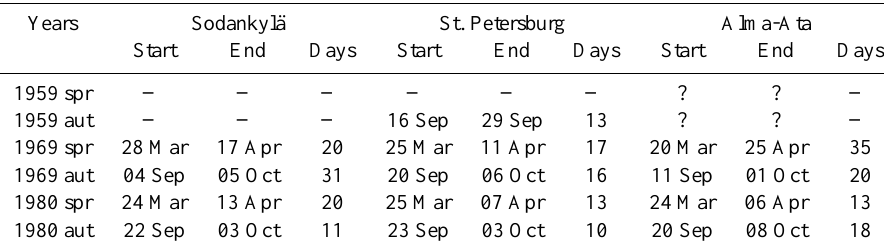
Table 2.2. Same as Table 2.1, but for solar maximum